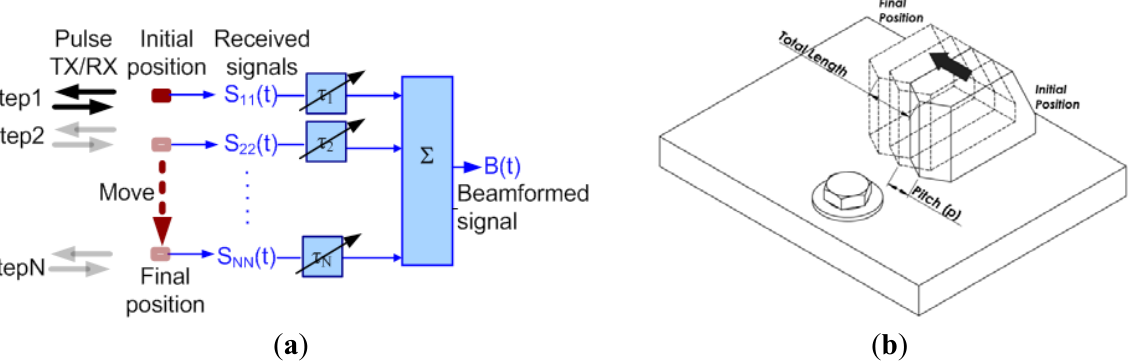
Figure 5. ( a ) Illustration of the synthetic aperture imaging and ( b ) the experimental